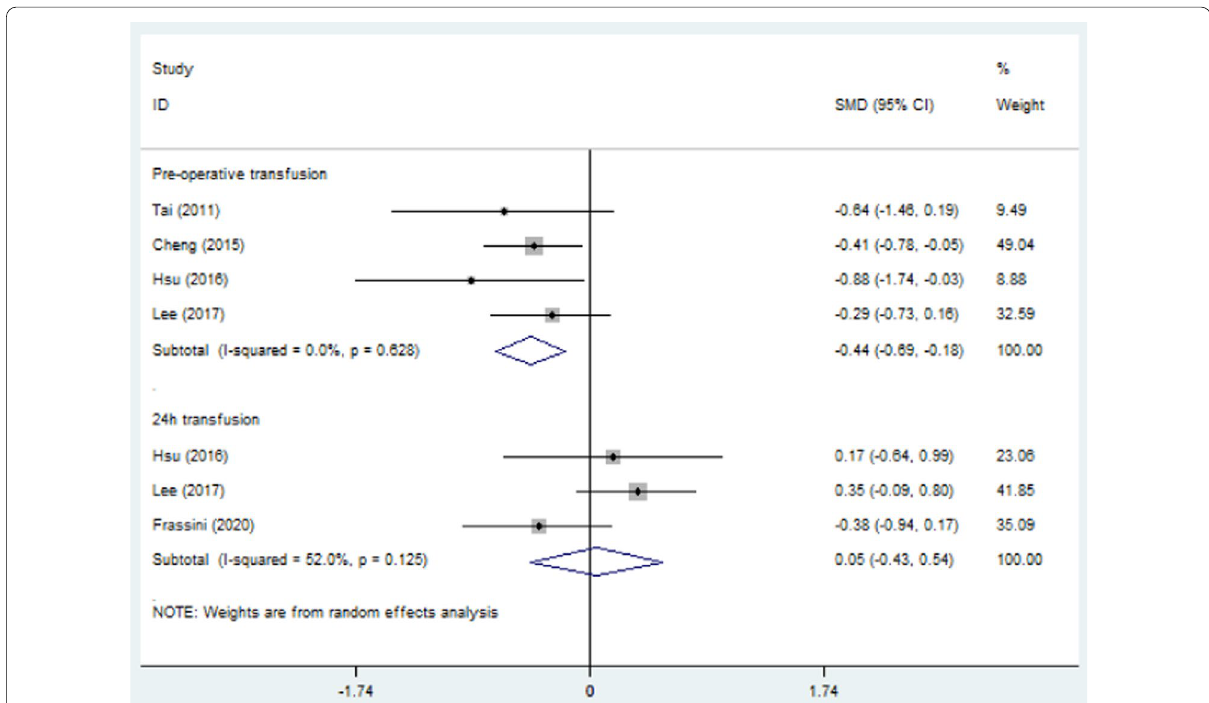
Fig. 6 Forest plot involving a comparison of pre-operative transfusion and transfusion during the first 24 h after admission. SMD standard mean difference, CI confidence interval